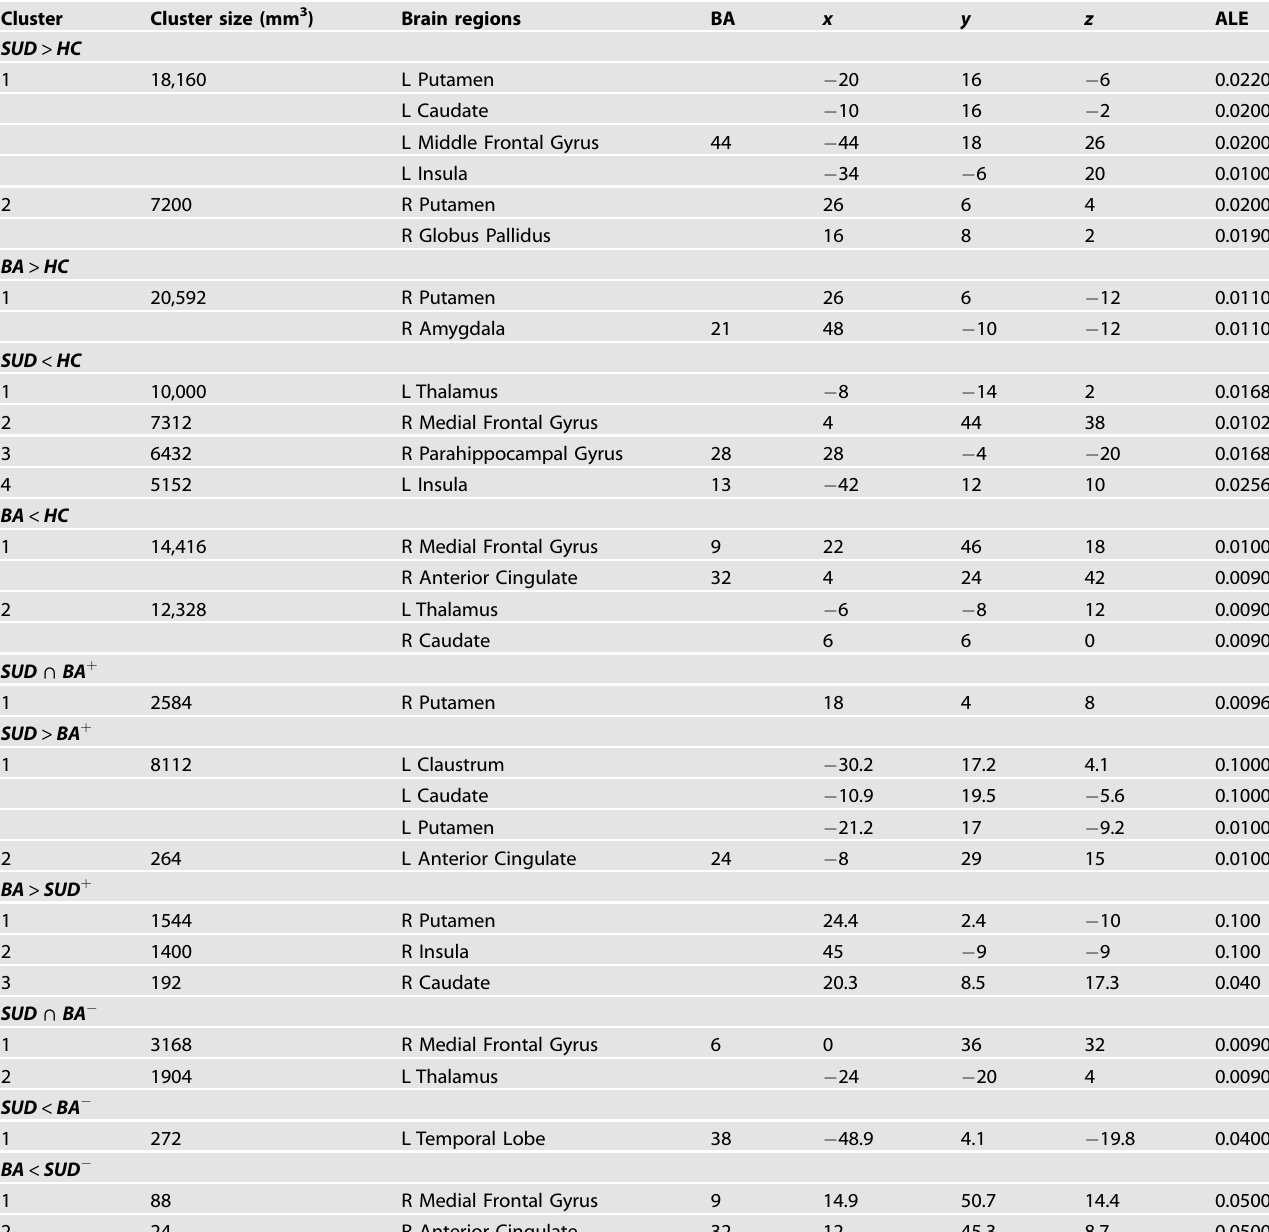
Table 2. Results of the meta-analysis of resting-state functional connectivity in SUD and